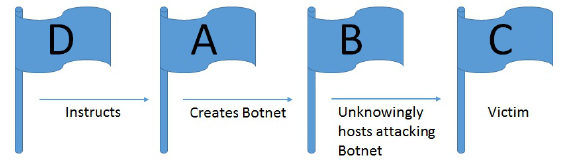
Figure 1. An illustration of the complexity of nation-state responsibility in